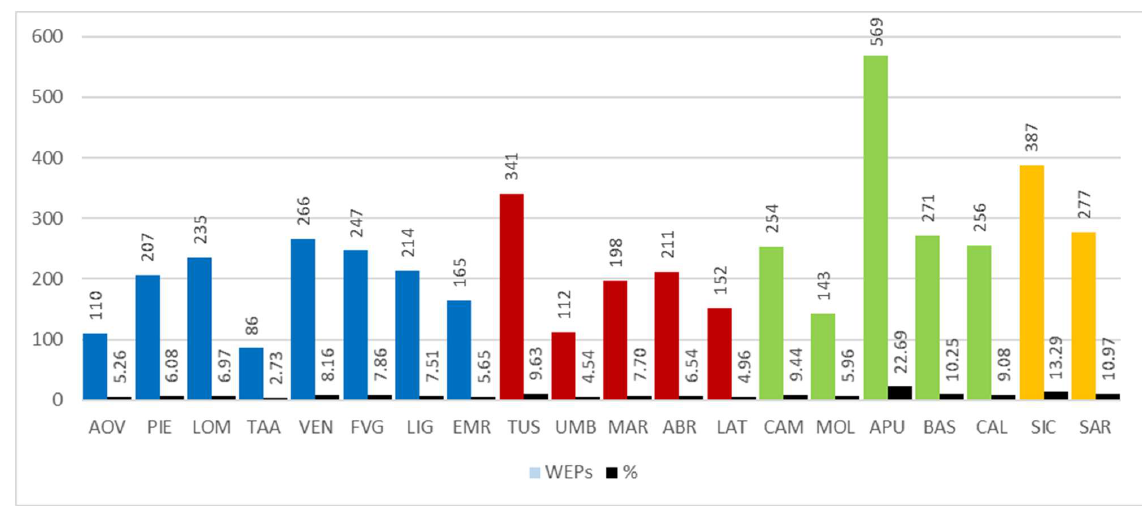
Figure 6. Number of Wild Edible Plants (WEPs) by region in respect of the percentage composition of taxa present in the regional flora. Abbreviations of the administrative regions are shown in Figure 1.